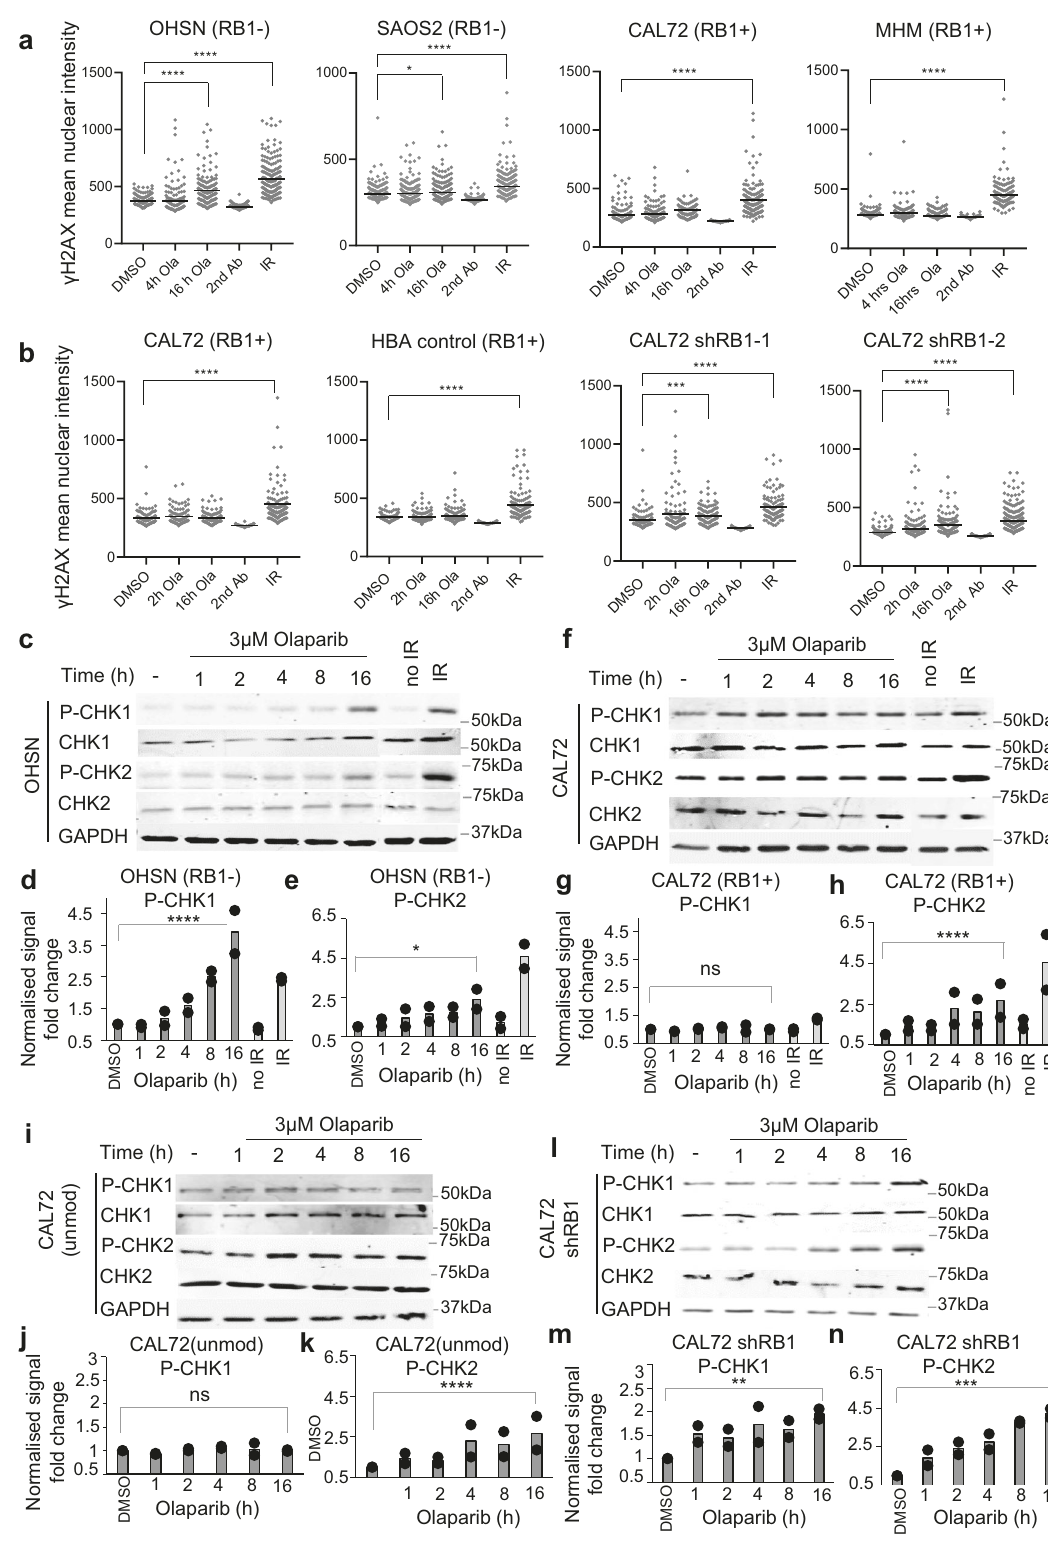
checkpoint functions 54 , events that instigate replication stress 55 , events that increase single-strand DNA breakage 56 , and loss of PARP1-dependent gene transcription 57 . Defects in serval of these processes, including DNA cohesion and chromatin remodelling 58 , and metabolic changes leading to